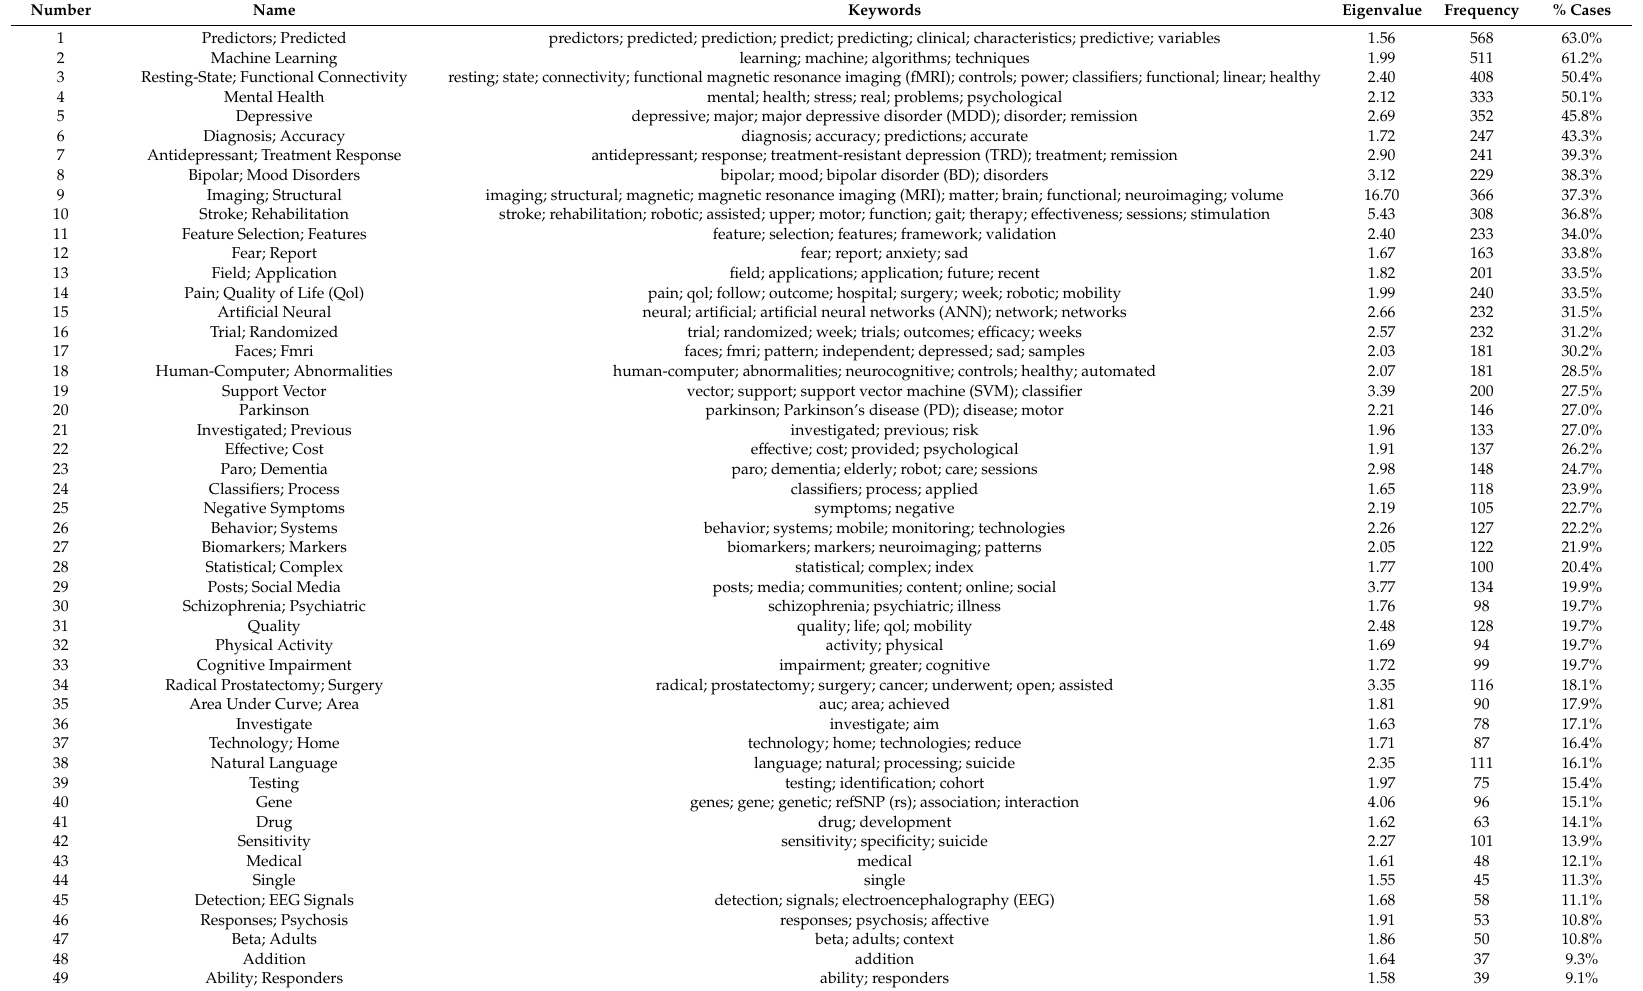
Table 4. Top 50 research domains emerged from exploratory factor analysis of all abstracts’